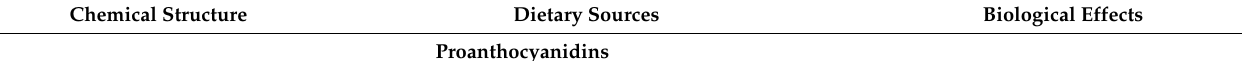
Proanthocyanidins Cinnamon, aronia fruit, cocoa beans, grape seed, grape skin, red wines, bilberry,